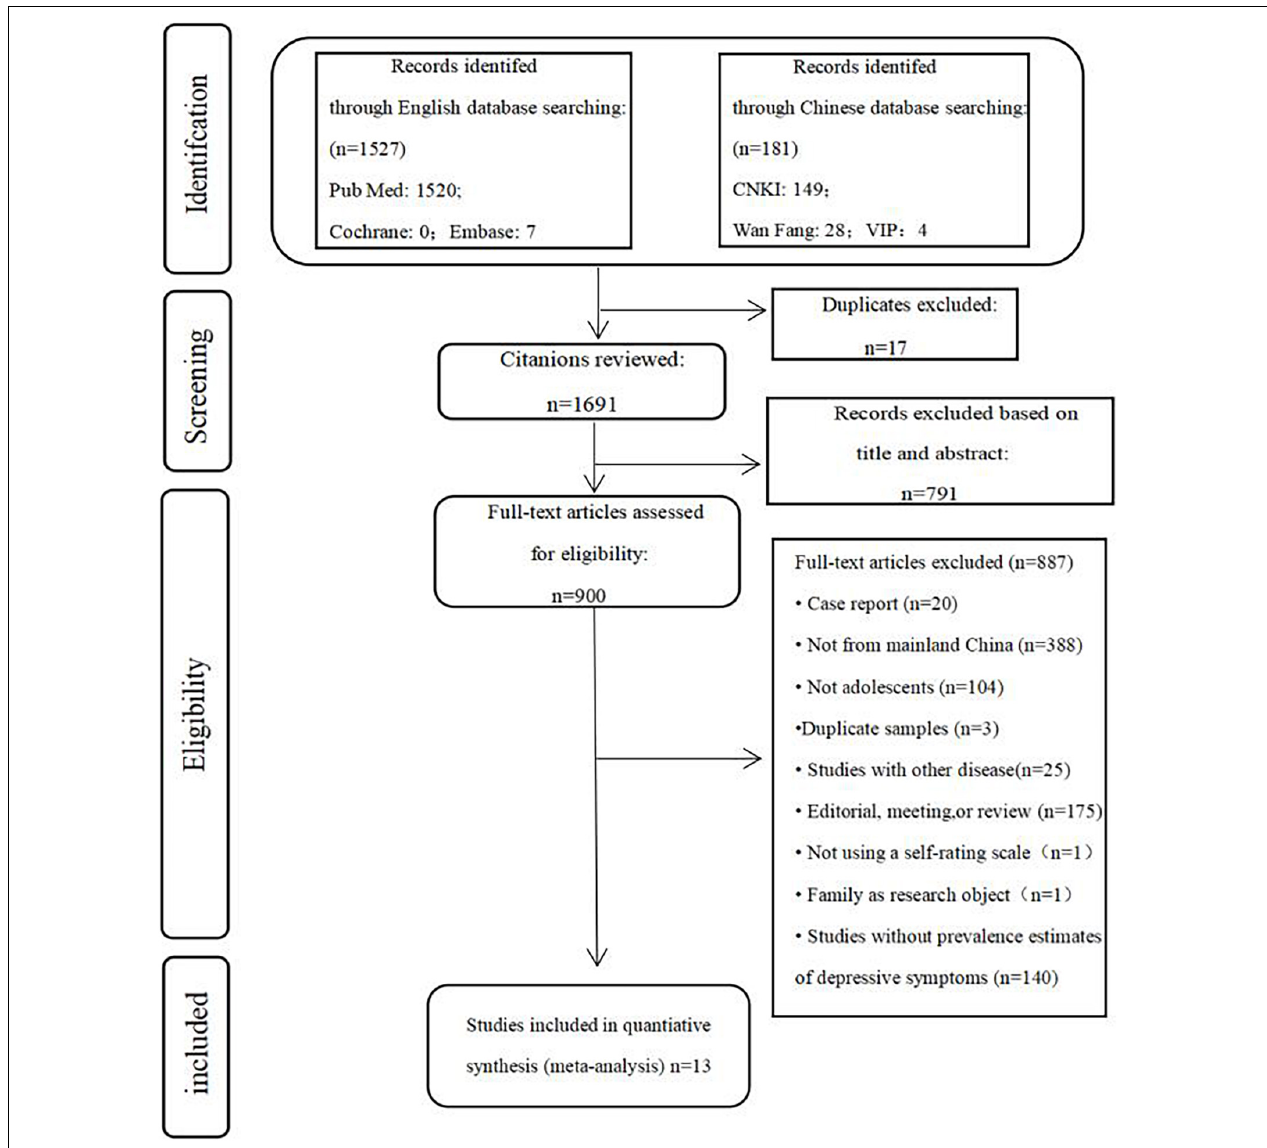
FIGURE 1 | PRISMA flowchart of study